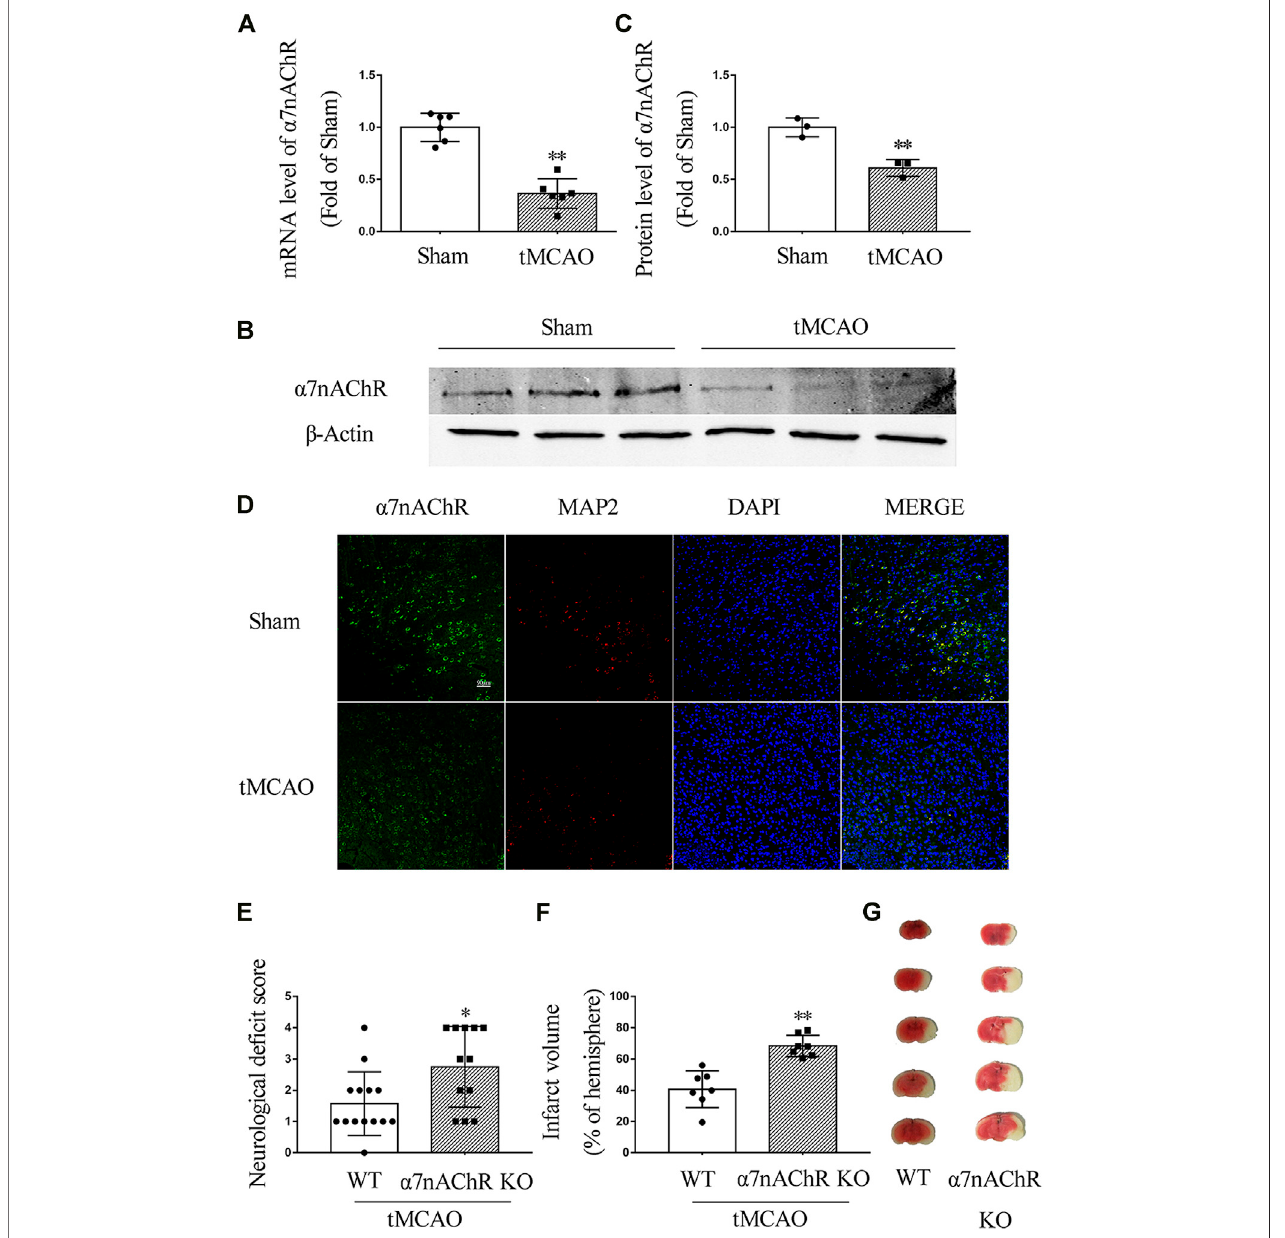
FIGURE1| α 7nAChRknockoutdeterioratesischemicstrokeintransientmiddlecerebralarteryocclusion(tMCAO)mice.Mousebrainwascollectedat24 hinwild- type(WT)miceand α 7nAChRknockout(KO)miceaftertMCAO surgery. (A) mRNAlevelinthepenumbralzone. n (cid:2) 6foreach group.** p < 0.01 vs. Sham. (B,C) Protein expression in the penumbral zone. n (cid:2) 3 for each group. ** p < 0.01 vs. Sham. (D) Representative immuno fl uorescence staining images of α 7nAChR, MAP2, and DAPI. Scalebar,90 μ m. (E) Neurologicalde fi citscore.* p < 0.05vs . WT. n (cid:2) 12 – 14foreachgroup. (F) Quanti fi cationofinfarctvolume;** p < 0.01 vs. WT. n (cid:2) 7pergroup. (G) Representative image of TTC